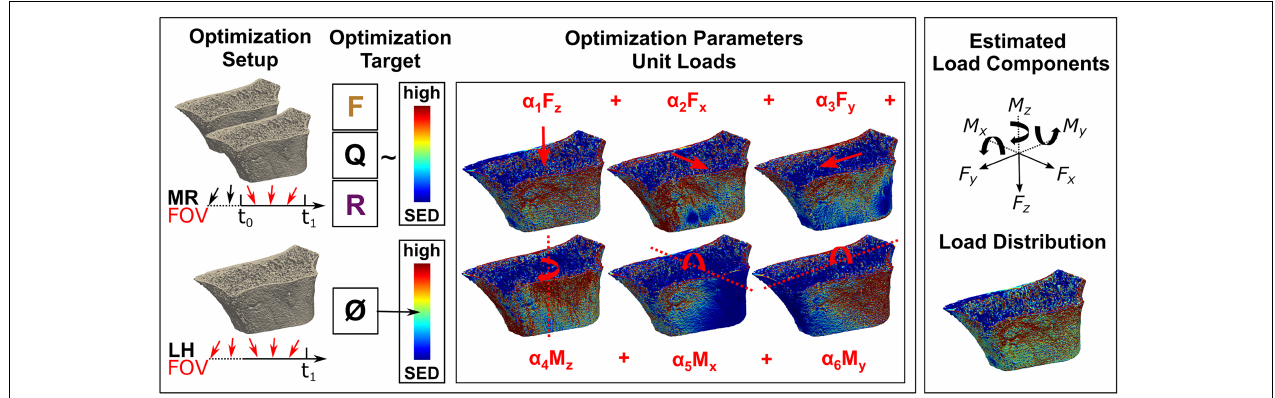
FIGURE 2 | Overview of the mechanoregulation-based load estimation (MR) algorithm and morphology-based load history (LH) algorithm. (Top left) In vivo loading is assessed by MR between two consecutive images, outlining the algorithm’s field of view (FOV). By overlaying registered longitudinal images, remodelling regions are identified to find a loading scenario maximising the correlation between formation (F) in regions of high strain, quiescence (Q) in regions of medium strain, and resorption (R) in regions of low strain. (Bottom left) In comparison, load history (LH) estimates the complete in vivo load history with no option to limit its FOV and targets a homogeneous strain distribution of medium strain (0.02 MPa). (Center) For the optimisation in both algorithms, micro-finite element (FE) models are created covering all physiologically possible loading directions. During the optimisation, unit loads are scaled until the optimisation target is achieved, providing (Top right) individual load components (i.e., forces and moments) as well as (Bottom right) a combined load